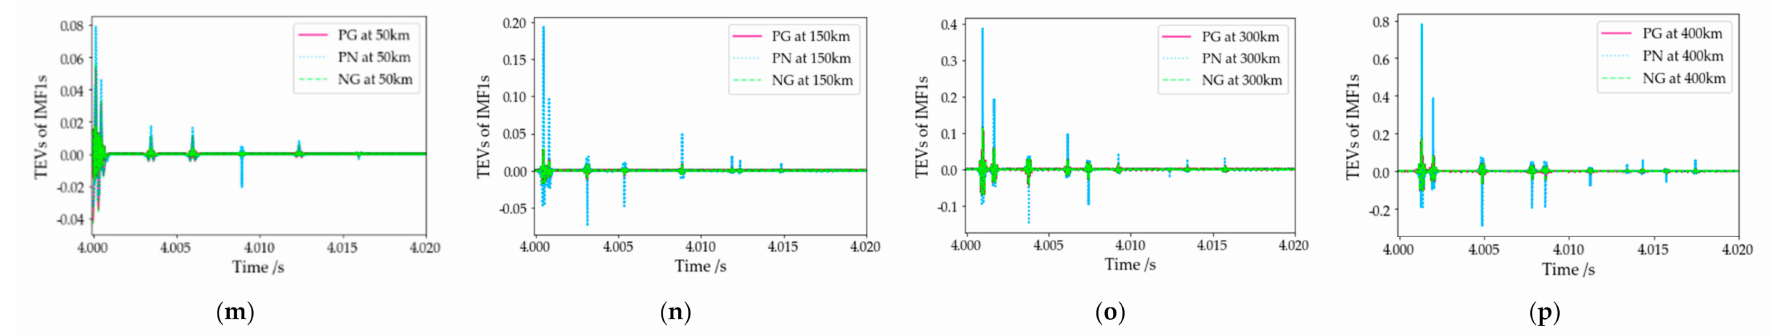
Figure 12. Partial samples when faults occur at 50, 150, 300 and 400 km. ( a – d ) Fault current without noise; ( e – h ) IMF1 of fault current by VMD; ( i – l ) fault voltage without noise; ( m – p ) TEVs of IMF1s in fault